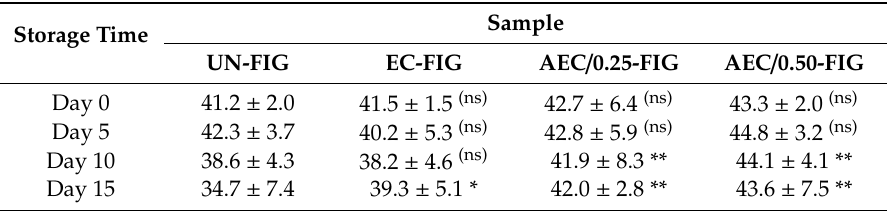
Table 2. Changes in total flavonoid contents (mg Catechin equivalents (CE) / 100 g FW) occurring after 5, 10, and 15 days of storage with di ff erent